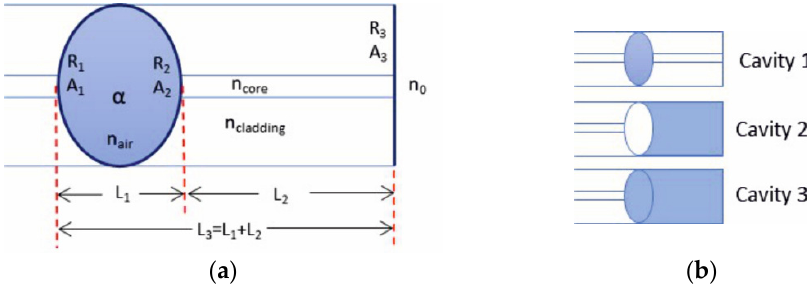
Figure 2. Schematic representations of the (a) head of the sensor and (b) the three-cavity model.